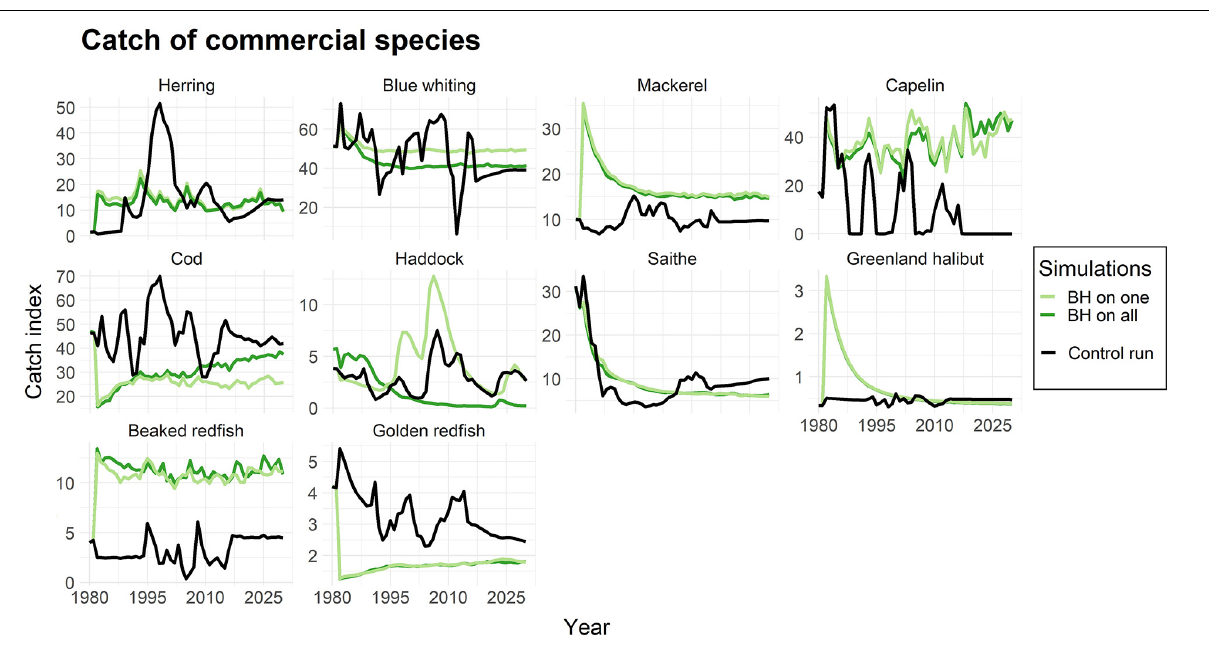
FIGURE 5 | The catches of commercial species when subjected to a BH regime. The light green line represents simulations were only that species were subjected to a BH regime, while the dark green line shows the biomass when all species in the study were subjected to BH. The black line represents the control run where a traditional fishing regime was applied. The catch is given as an